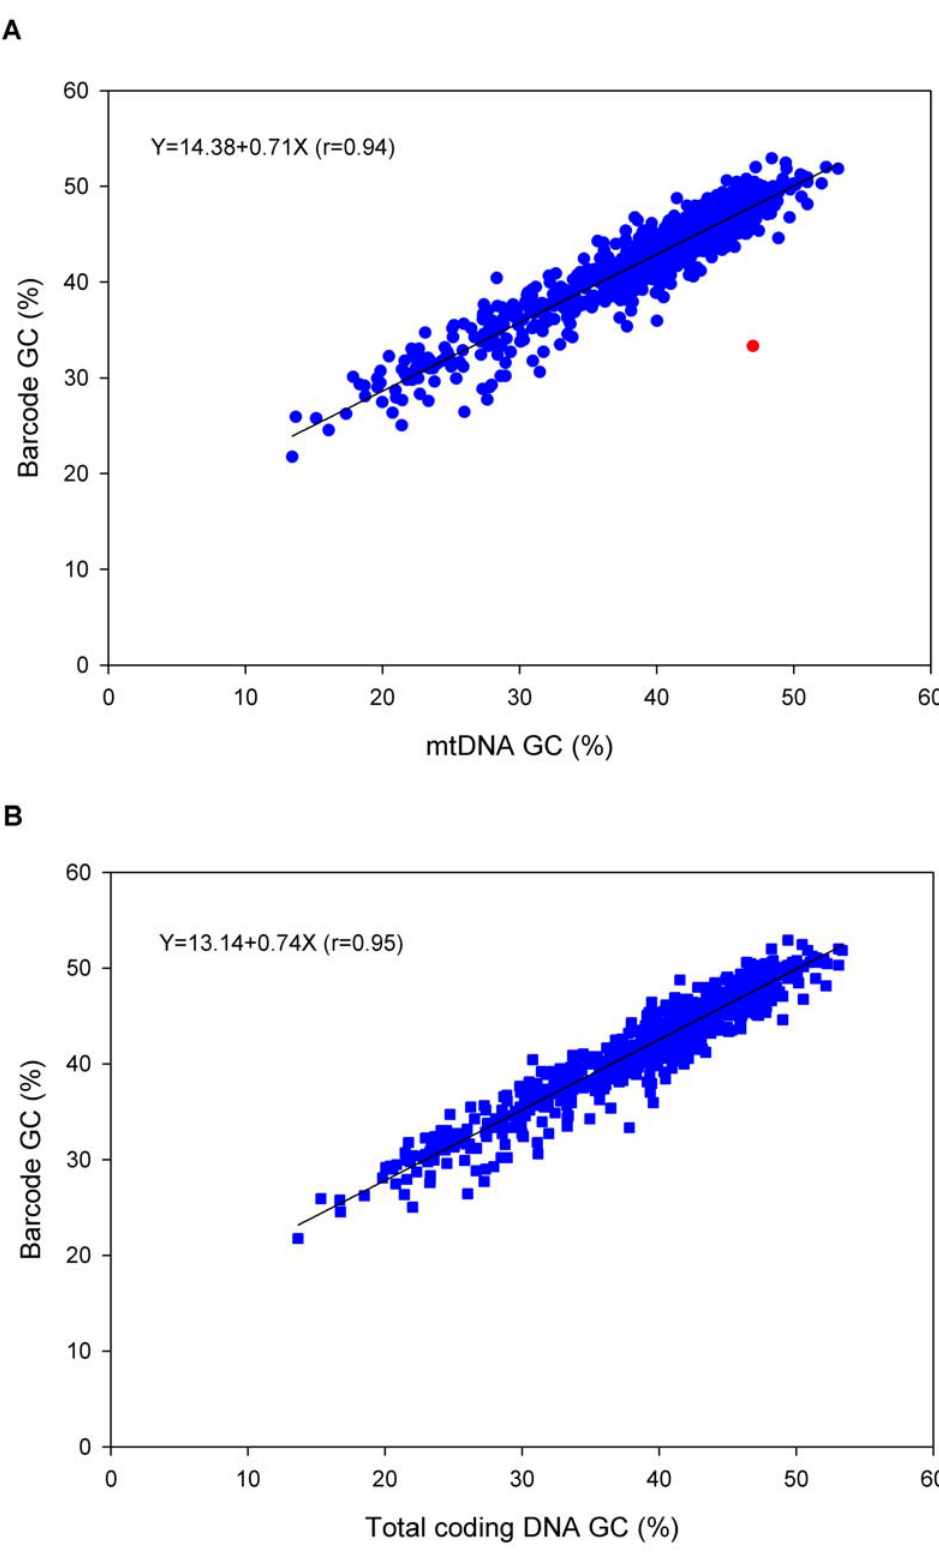
Figure 1. Correlation between nucleotide content of DNA barcodes and the nucleotide content of the mitochondrial genome. Panel A shows the GC content of the DNA barcodes plotted against the GC content of the entire mitochondrial genome (including protein-coding and non-coding sequences). The outlier point (shown in red) is from Trichoplax adhaerens (NC_008151). Panel B shows the DNA barcode GC content plotted against the GC content of the combined protein-coding sequences only.